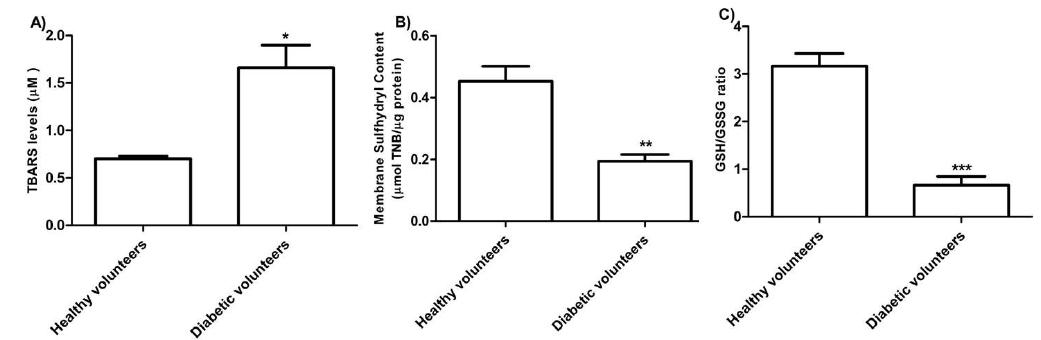
significant versus control as determined by the Student’s t -test ( n = 8). ( B ) Membrane sulfhydryl content measured as µ mol TNB / µ g protein in healthy volunteers (control) and diabetic volunteers. ** p < 0.01 significant versus control as determined by the Student’s t -test ( n = 8). ( C ) Estimation of the GSH / GSSG ratio in erythrocytes from healthy volunteers (control) and diabetic volunteers. *** p < 0.001 significant versus control as determined by the Student’s t -test ( n =